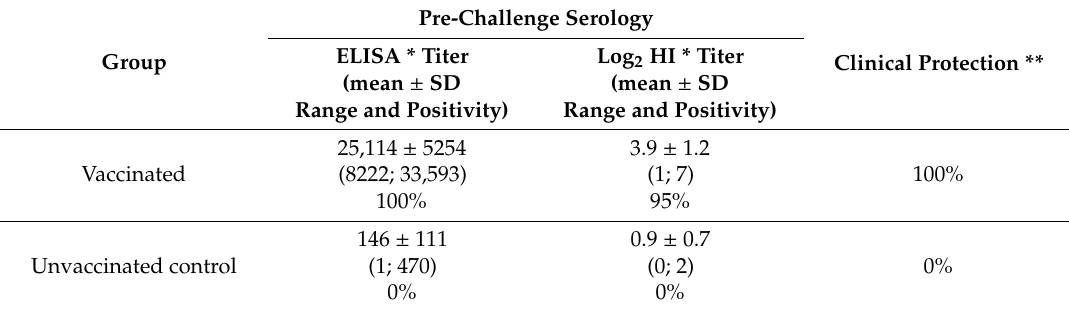
Table 2. Pre-challenge serological results and clinical protection against vNDV